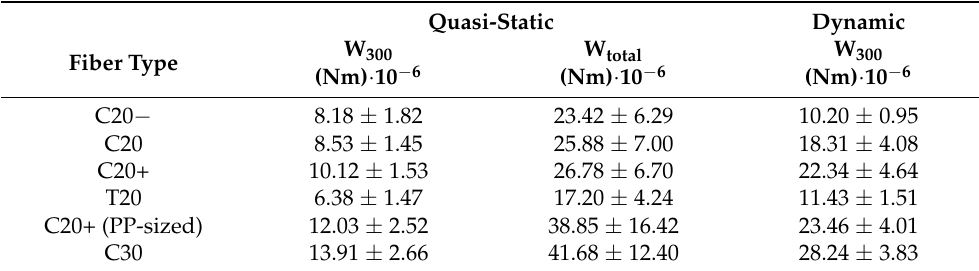
Table 7. Calculated pull-out work for a displacement of 300 µ m (W 300 ) for quasi-static and dynamic loading and full pull-out for quasi-static loading (W total